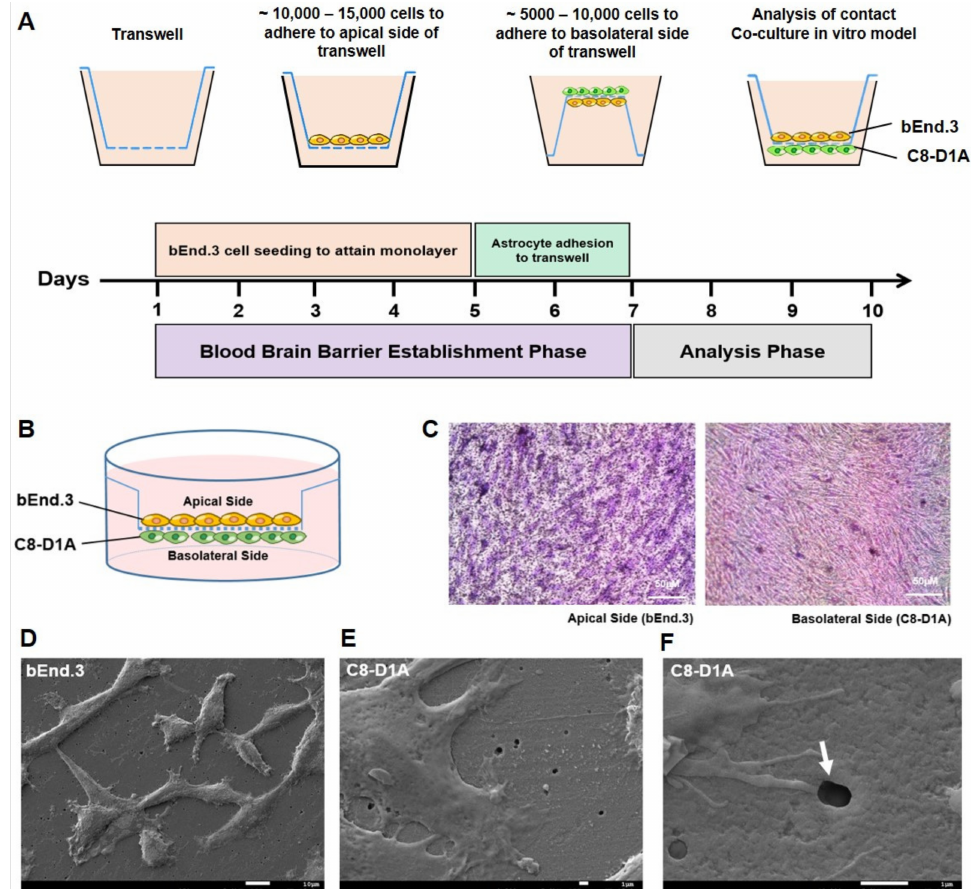
Figure 1. The establishment of a co-culture in vitro BBB model. ( A ) Schematic timeline representation of bEnd.3 and C8-D1A cell seeding on apical and basolateral sides of the transwell to attain a contact co-culture in vitro BBB model. ( B ) Graphical representation of intact contact co-culture in vitro BBB model. ( C ) Hematoxylin and eosin (H&E) stained transwell membrane shows adherent bEnd.3 and C8-D1A cells on the apical and basolateral side. ( D – F ) Scanning electron micrographs of transwell membrane at low confluency of cells show ( D ) bEnd.3 cells on the apical side ( × 950) and ( E ) C8-D1A cells on the basolateral side of the transwell membrane ( × 3500). ( F ) Magnified micrograph ( × 19,000) shows C8-D1A cell end-feet processes on the basolateral side passing through 0.4 µ m pore